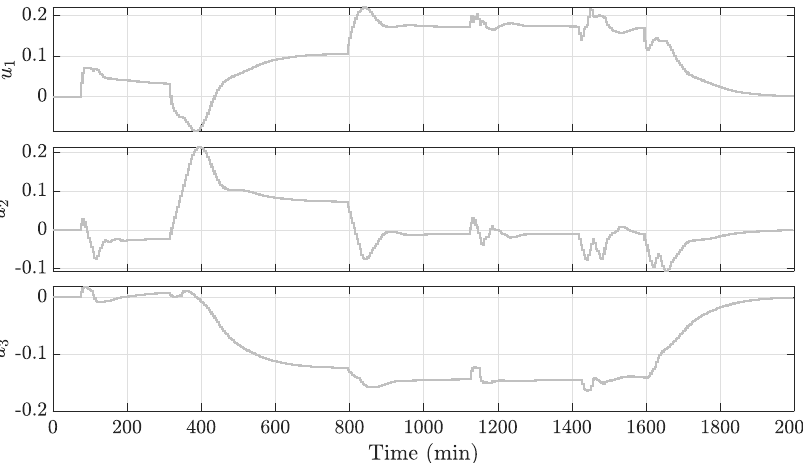
Figure 16. Case 2—Manipulated variables of the HOF with